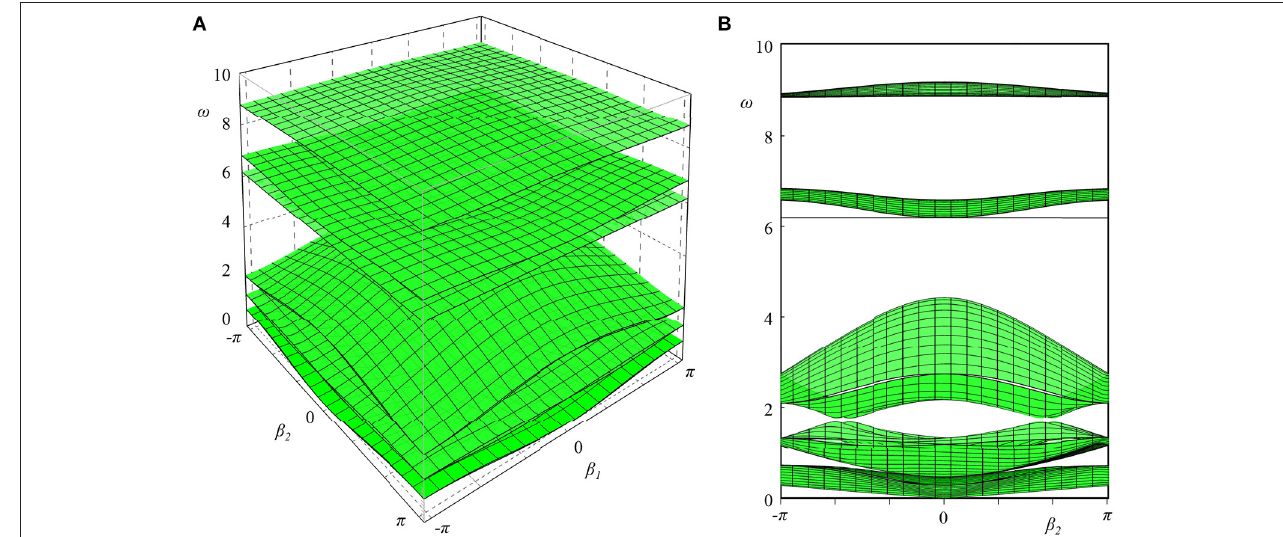
FIGURE 10 | Dispersion spectrum for the optimized beam lattice model of the anti-tetrachiral metamaterial: (A) 3D view and (B) 2D view.